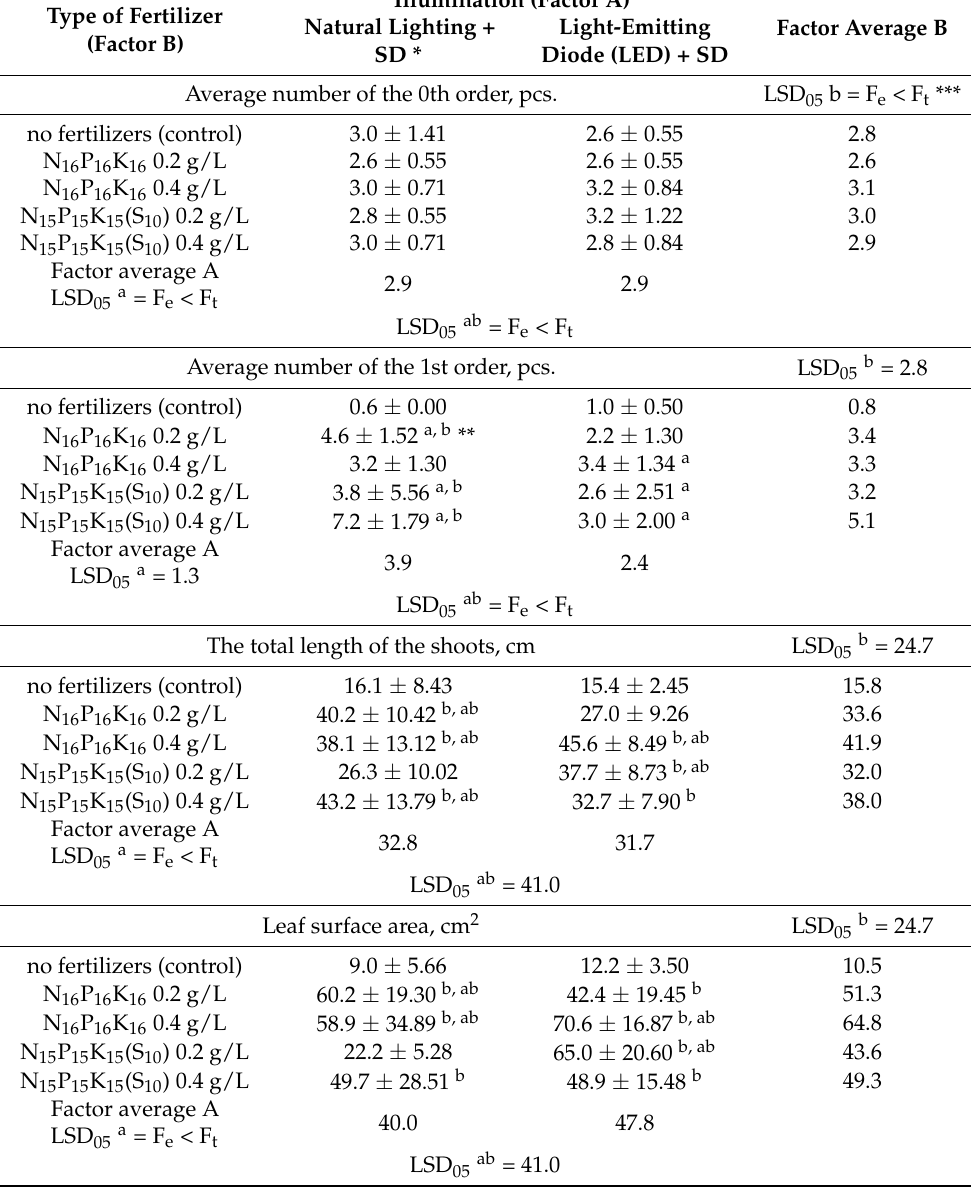
Table 3. Morphometric indicators of ex vitro development in highbush blueberry ( Vaccinium corymbo- sum L.) plants cv. Brigitta Blue on the 42nd day of growing completion. Illumination (Factor A) Type of Fertilizer Light-Emitting Factor Average BNatural Lighting + (Factor B) SD * Diode (LED) + SD Average number of the 0th order,